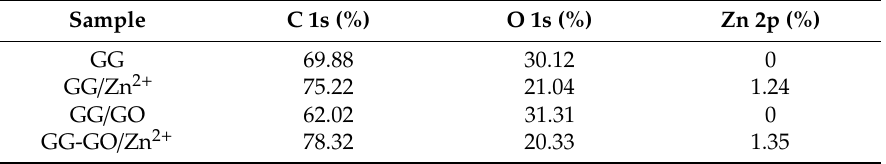
Figure 5. XPS spectra for GG; GG/GO before and after sorption of Zn (II).